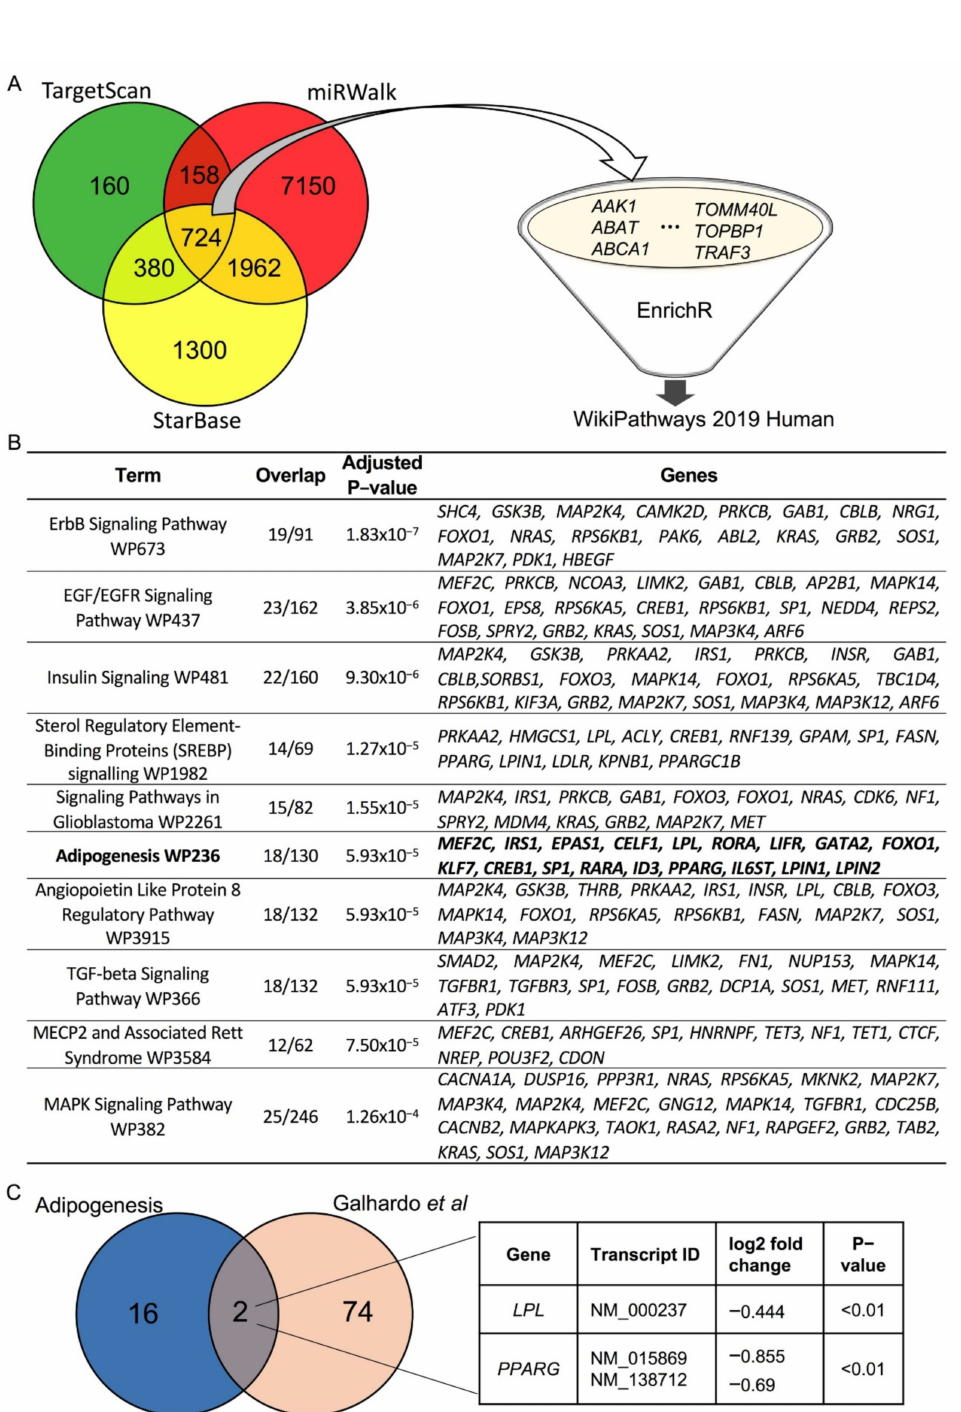
Figure 5. In silico screening for miR-27a-3p targets related to adipogenesis. To identify predicted targets of miR-27a-3p that are involved in adipogenic processes, an intersection analysis with the results of the three databases Targetscan, miRWalk, and Starbase followed by an enrichment analysis using EnrichR was performed [30]. ( A ) Schematic illustration of the in silico analysis. ( B ) Results of the enrichment analysis with EnrichR using WIKIpathway. ( C ) Intersection analysis with genes enriched in the term “Adipogenesis” and target genes of miR-27a shown to be regulated by miR-27a-mimic transfection by Galhardo et al. with log2 fold changes and p -values [31]. LPL: lipoprotein lipase; PPAR γ : peroxisome proliferator-activated receptor γ